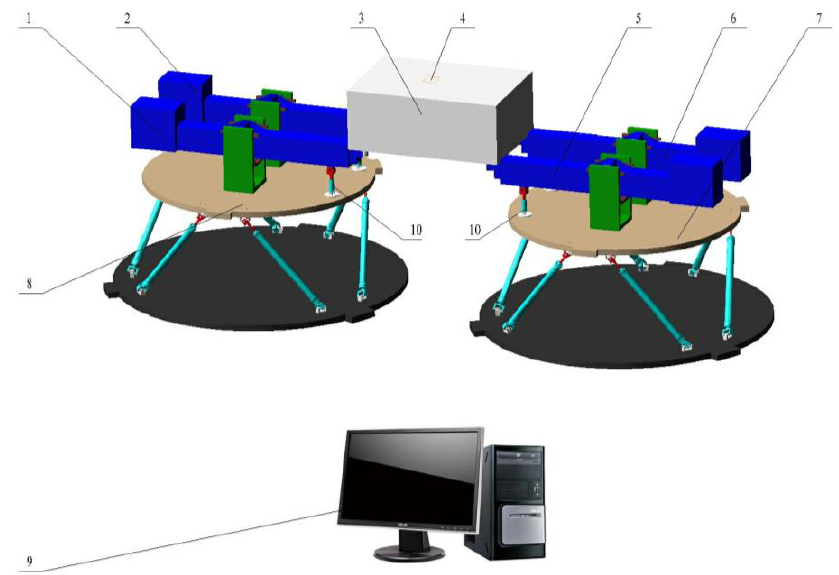
Figure 2. Model experimental device of the integrated dismantling scheme. In the schematic: 1—the first lifting arm; 2—the second lifting arm; 3—analog object lifted; 4—attitude sensor; 5—the third lifting arm; 6—the fourth lifting arm; 7—the second six-degrees-of-freedom vibration platform; 8—the first six-degrees-of-freedom vibration platform; 9—industrial control computer; 10—servo electric cylinder.